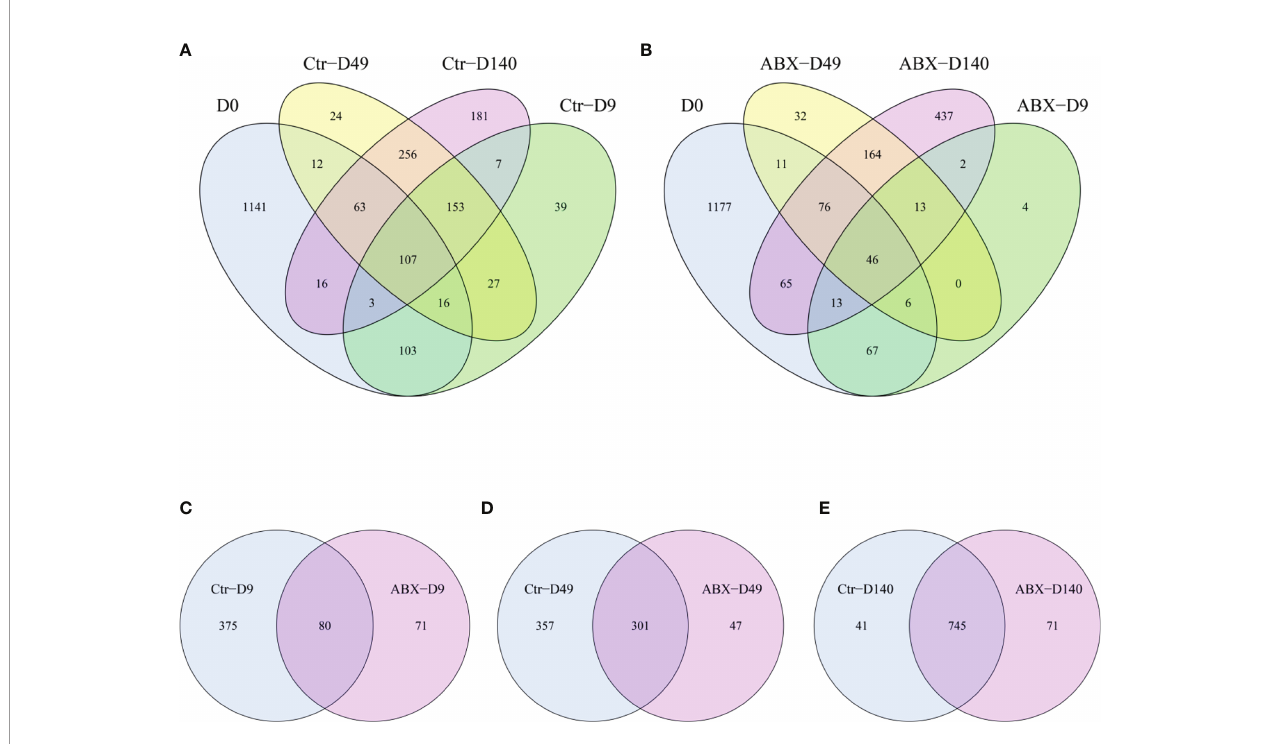
FIGURE 3 | Overall structural changes in gut microbiota with antibiotic treatment. (A) Differences in the distribution of operational taxonomic units (OTU) at different ages in the controls (Ctr) were analyzed using Venn diagrams. (B) Differences in the distribution of OTU at different ages in birds treated with antibiotics (ABX) were analyzed using Venn diagrams. (C) Differences in OUT between Ctr and ABX on day 9 of antibiotic treatment, (D) on day 49 of antibiotic treatment, and (E) day 140. n ≥ 8 for each